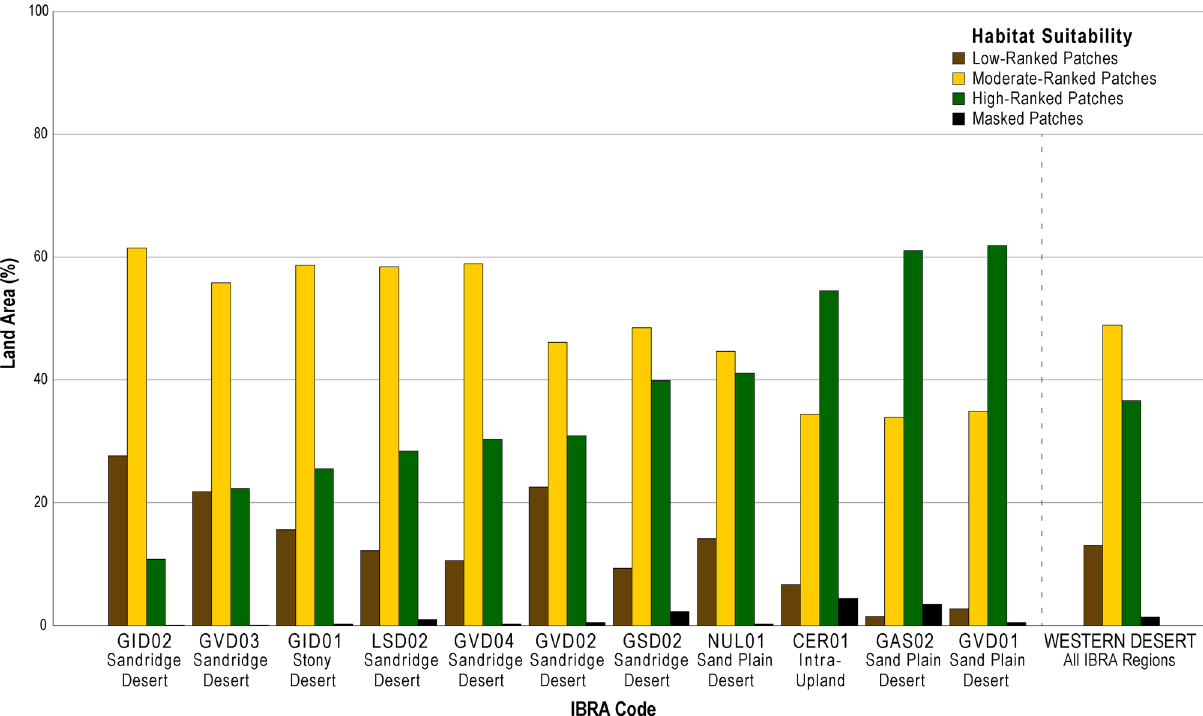
Figure 4. Percentage of land area (km 2 ) occupied by low, moderate, and high-ranked habitat suitability patches for the eleven largest IBRA bioregions of the Western Desert (Table S1). The histogram is ordered left to right based of the percentage of high-ranked foraging habitat within each bioregion. The percentages for the entire Western Desert are presented on the far